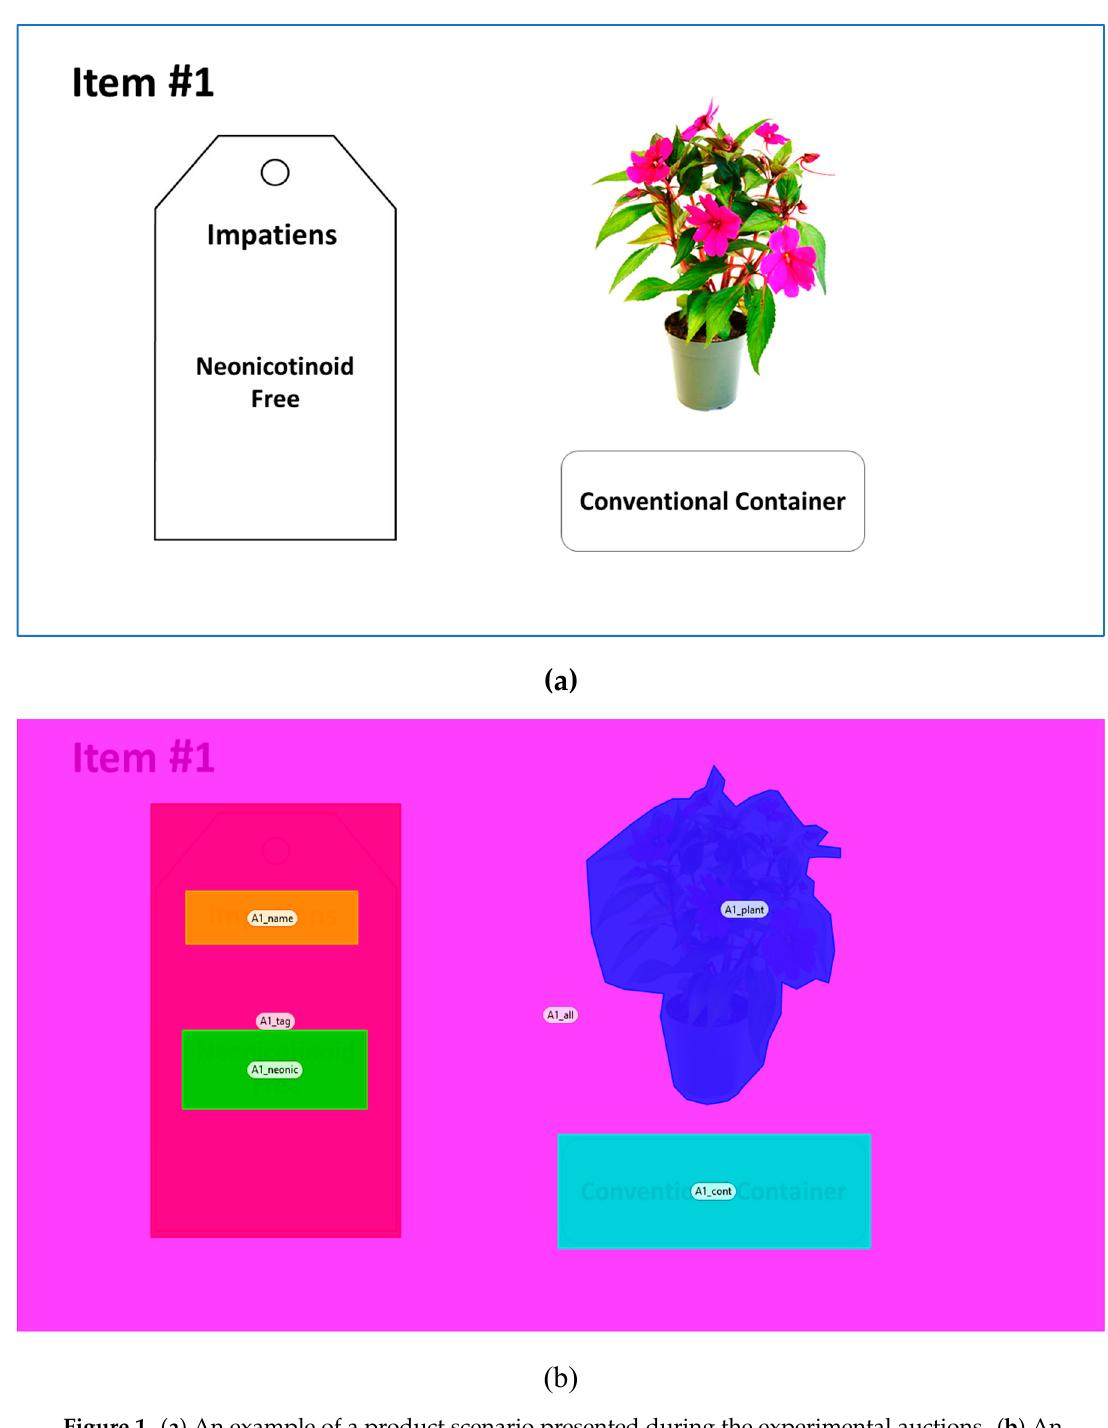
Figure 1. ( a ) An example of a product scenario presented during the experimental auctions. ( b ) An example of areas of interests used to extract visual attention measures after the auction experiments. Note: The areas of interest named A1_name, A1_neonic, A1_plant, and A1_cont indicate the plant name, labeling, plant image, and the container type, respectively.